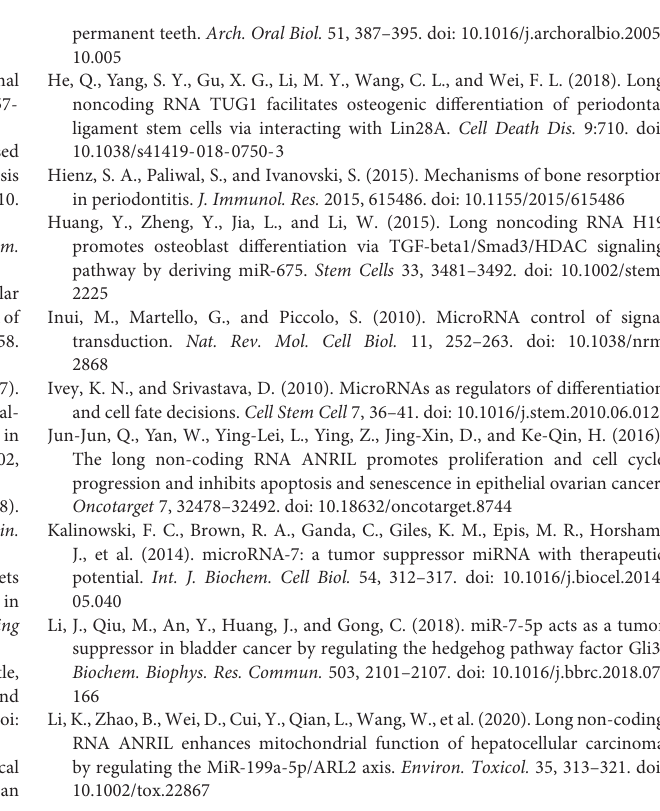
Supplementary Figure 1 | Phenotype identification of hPDLSCs. (A) The morphology of second-generation hPDLSCs. (B) Immunofluorescence assay showed that cultured hPDLSCs were positive for STRO-1. (C) The expression of CD29, CD73, CD90, CD105, CD34, and CD45 was detected by flow cytometry analysis. (D) Tri − lineage differentiation of hPDLSCs was performed in vitro . Scale bar = 100 µ m. Supplementary Figure 2 | Phenotype identification of iPDLSCs. (A) The morphology of second-generation iPDLSCs. (B) Immunofluorescence assay revealed that cultured iPDLSCs were positive for STRO-1. (C) Flow cytometry analysis showed that iPDLSCs were positive for CD29, CD73, CD90, and CD105, and negative for CD34 and CD45. (D) Tri − lineage differentiation of IPDLSCs was performed in vitro . Scale bar = 100 µ m. Supplementary Figure 3 | (A) The transfection efficacy of ANRIL was measured by qRT-PCR. (B) The transfection efficacy of miR-7-5p mimics and inhibitor was determined by qPCR. (C) The transfection efficacy of ANRIL was measured by qRT-PCR. (D) The transfection efficacy of miR-7-5p mimics and inhibitor was determined by qPCR ( ∗ P < 0.05, ∗∗ P < 0.01, ∗∗∗ P <